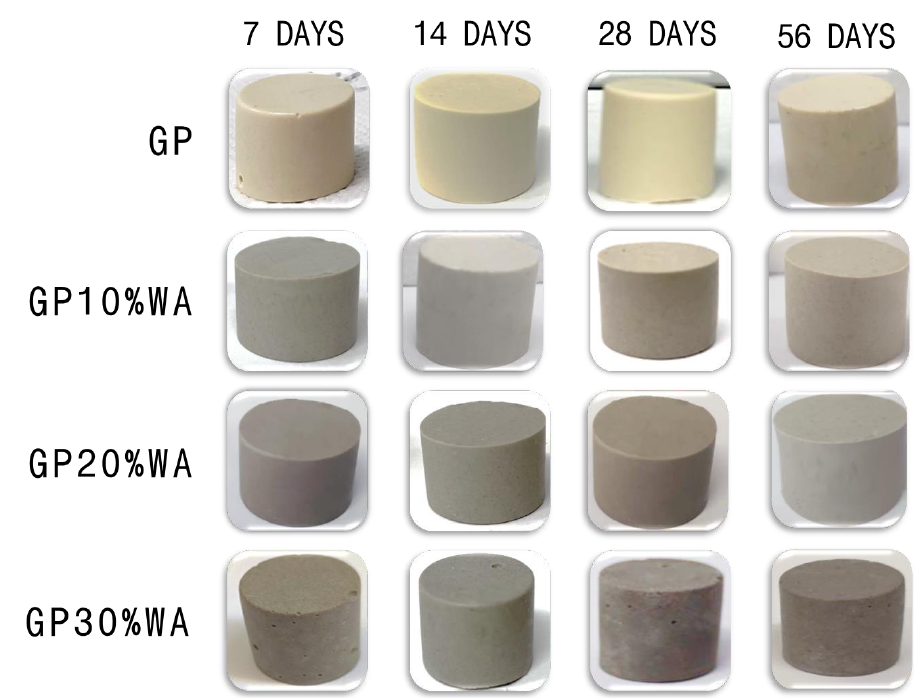
Figure 4. De-molded samples at different aging times.